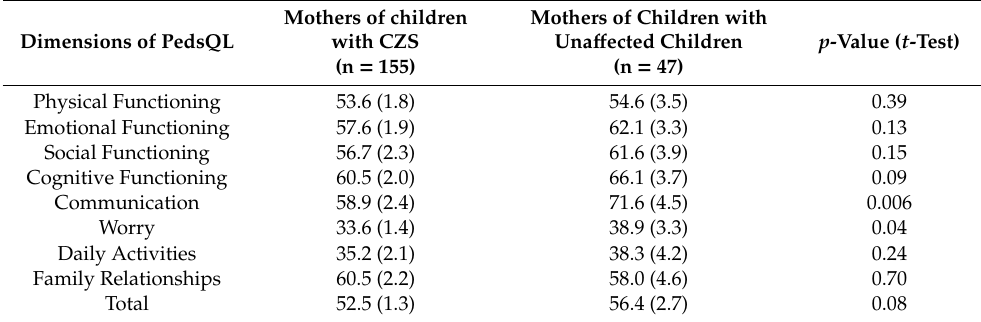
Table 3. The results of the PedsQL Family Impact Module comparing mothers of children with CZS to mothers of una ff ected